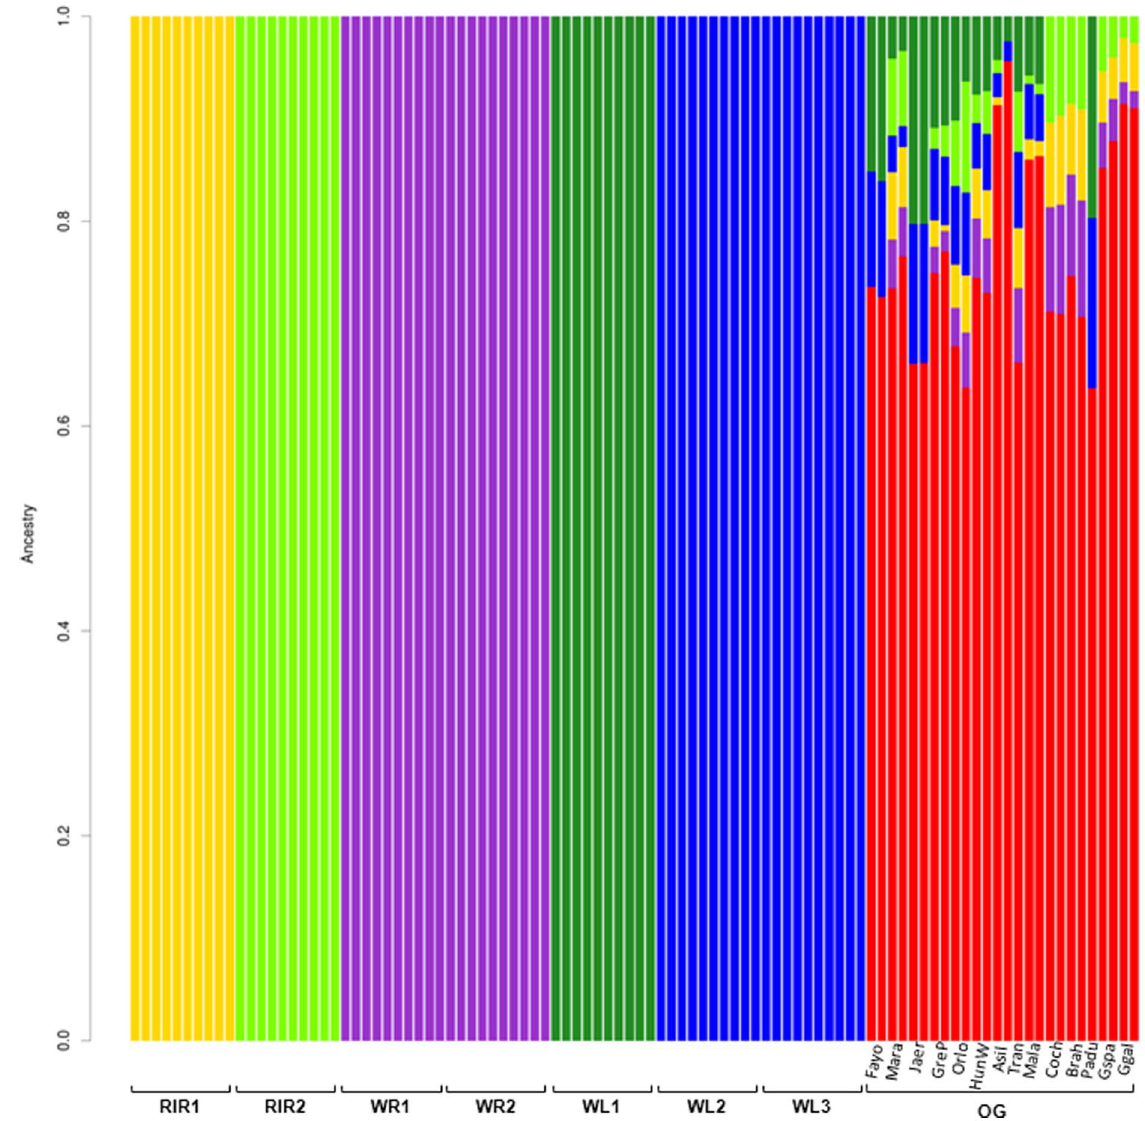
Figure 2. Result of ADMIXTURE structural analysis with null hypothesis of six breeds. Two rightmost individuals in OG are Gallus gallus gallus, and the third and fourth last individuals are Gallus gallus spadiceus. two brown egg-layer breeds (RIR and WR) were separated from each other by component 2. The outgroup is rather diverse and stays in the center of the distribution. As expected from the Lohmann breeding program, line two and line three of White Leghorns, and both lines in White Rock clustered together, respectively.